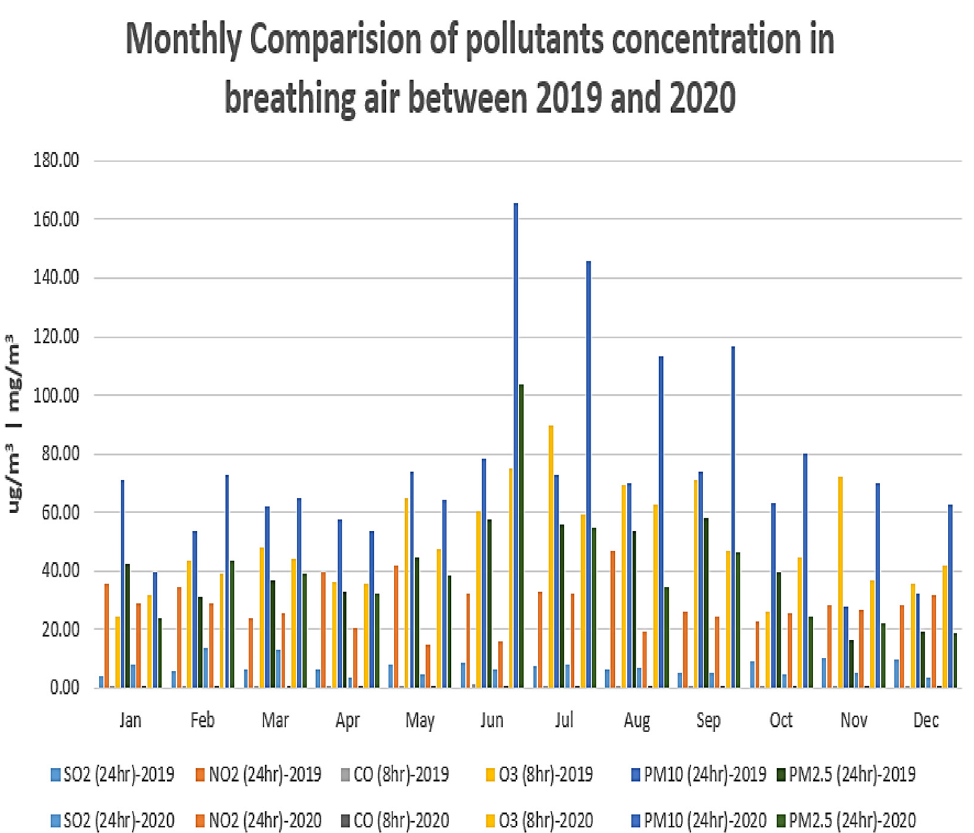
Fig. 7. Concentration of all elements of air quality compared between 2019 and 2020 [24] (see Supplementary